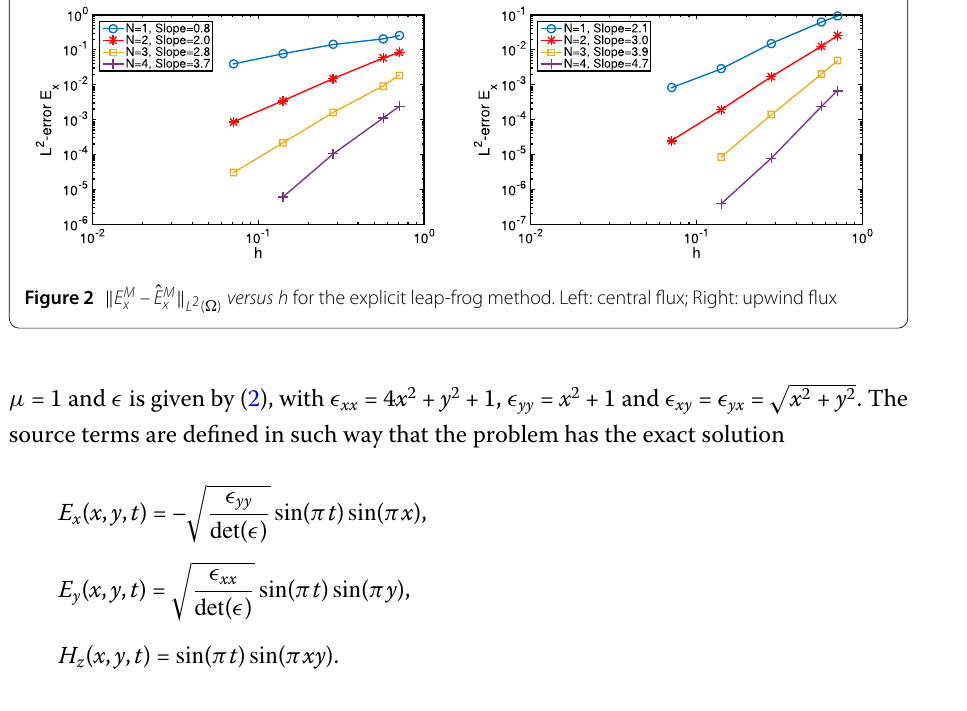
μ = 1 and (cid:3) is given by (2), with (cid:3)